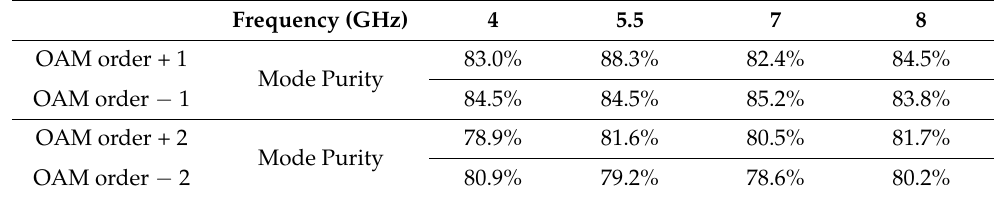
Table 2. Measured OAM purities of the reflected